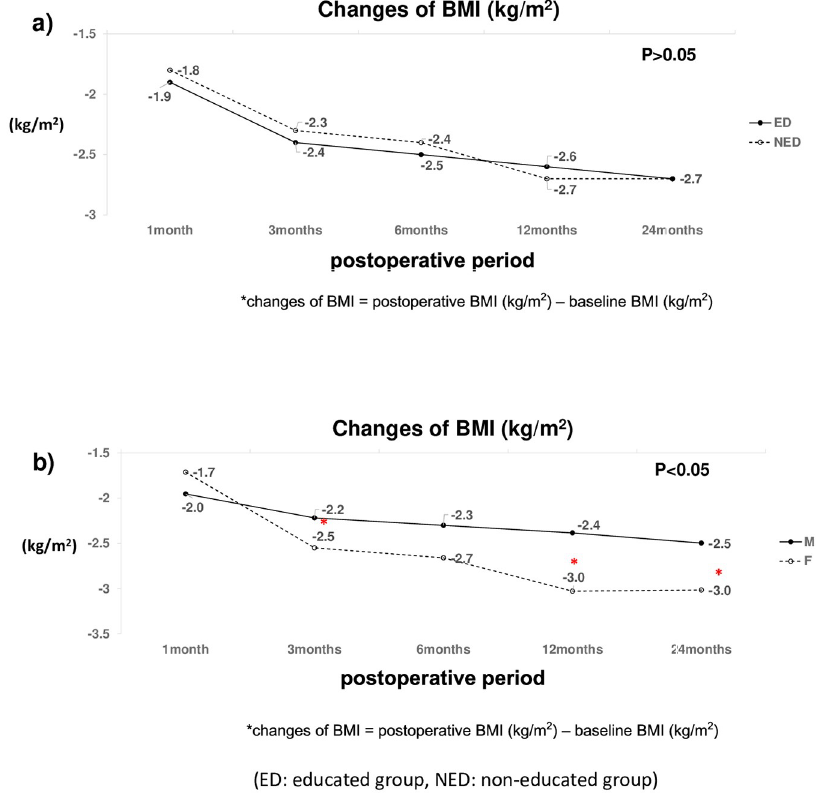
Fig 3. Changes in Body Mass Index (BMI) according to dietary education (a) and Gender (b). Changes in BMI, postoperative BMI (kg/m 2 ), baseline BMI (kg/m 2 ); ED: Educated group; NED: Non-educated group.